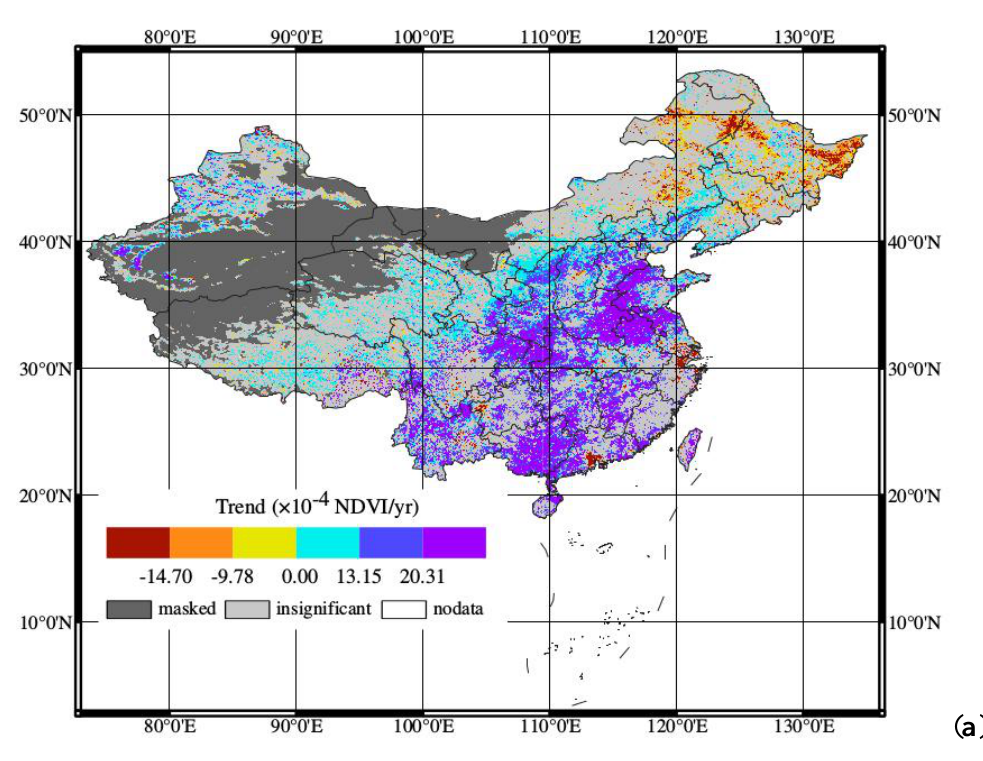
Figure 3. Trends of ( a ) annual mean; ( b ) annual minimum and ( c ) annual standard deviation of NDVI in study area. White pixels represent no data, light gray pixels indicate an insignificant trend, and dark gray pixels are masked with threshold of 30-year mean NDVI <